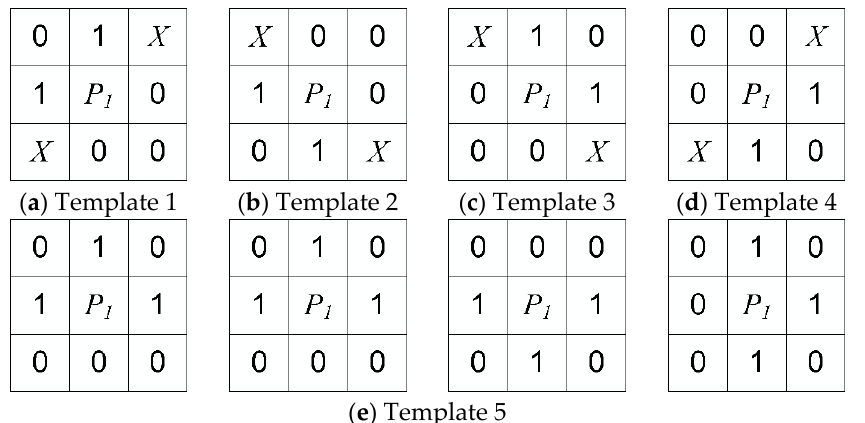
Figure 11. Spurious branches of skeleton. In this research, the obstacle convex hull is constructed to obtain the navigable re- gion with smooth outline. The flow chart in Figure 12 describes the detail of convex hull transform for the grid map.